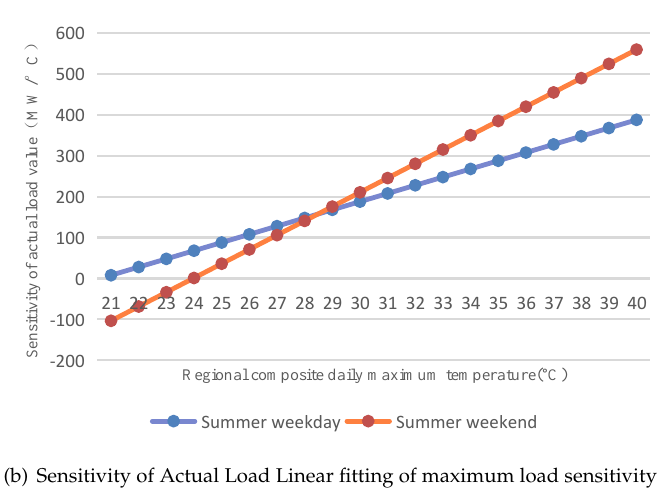
Figure 1. Comparison of weekend load and weekday load